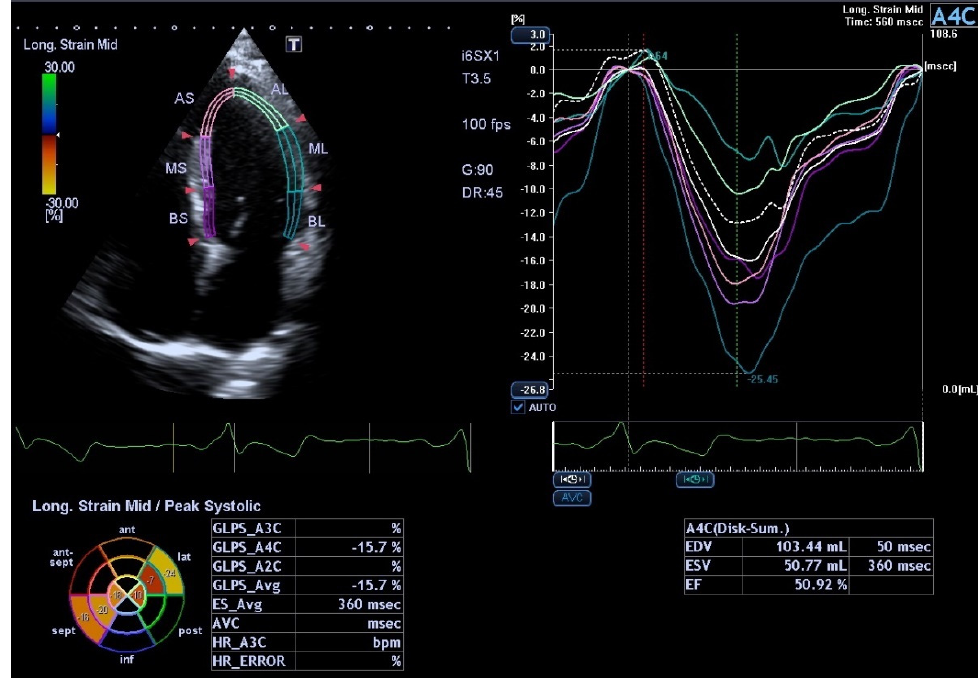
Figure 3. Left ventricular function analysis in a pregnant patient, 4 chamber apical view. AS—apical septal, AL—apical lateral, ML—mid lateral, MS—mid septal, BL—basal lateral, BS—basal septal, EDV—end-diastolic volume, ESV—end-systolic volume, EF—ejection fraction .